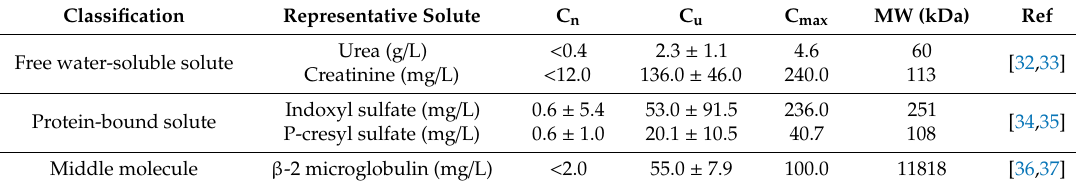
Table 1. Physiochemical classification of Uremic Toxins by the EuTox Work Group.